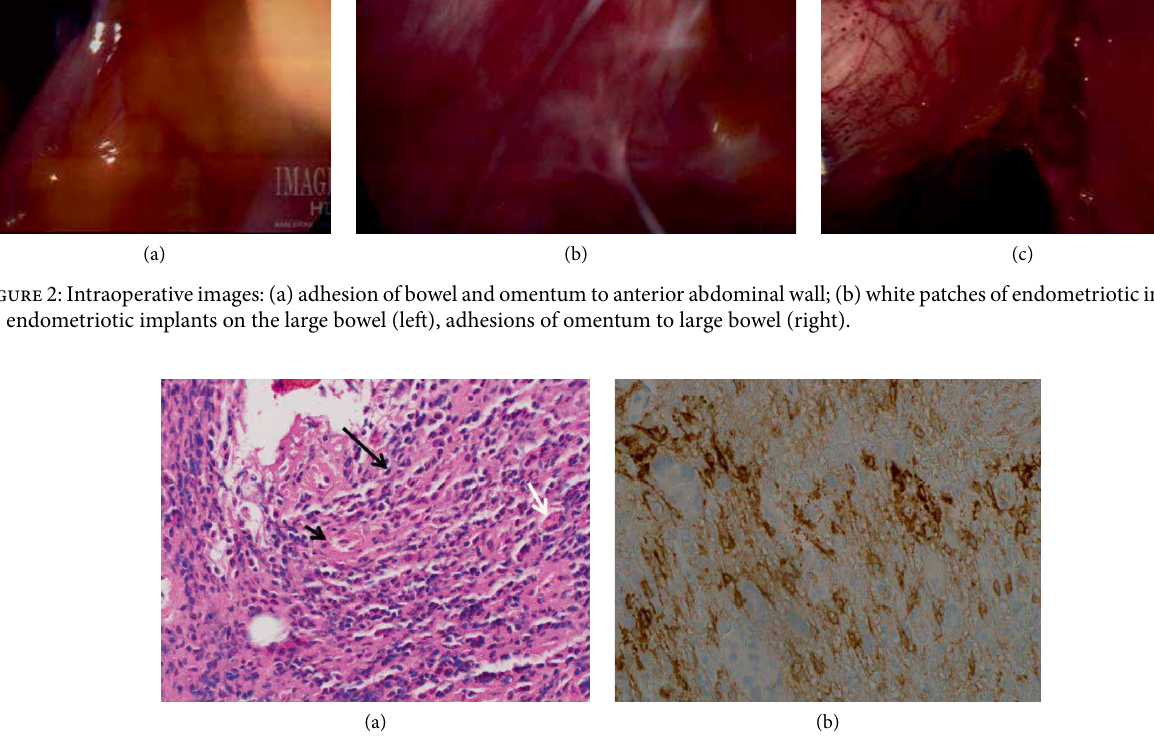
Figure 3: Pathology slides: left external iliac nodule biopsy: (a) endometrial-type stroma (long black arrow) and capillary (short black arrow) with hemosiderin-laden macrophage (white arrow). (H&E stain); (b) endometrial-type stroma is positive for CD10 (CD10 immunohistochemical